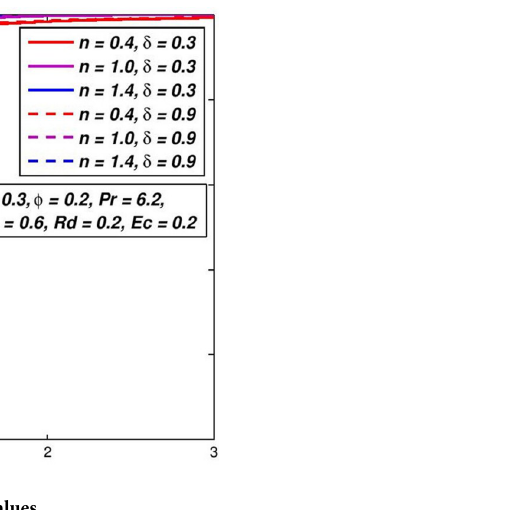
Fig 12. Effect of δ on f 0 ( η ) for diverse n